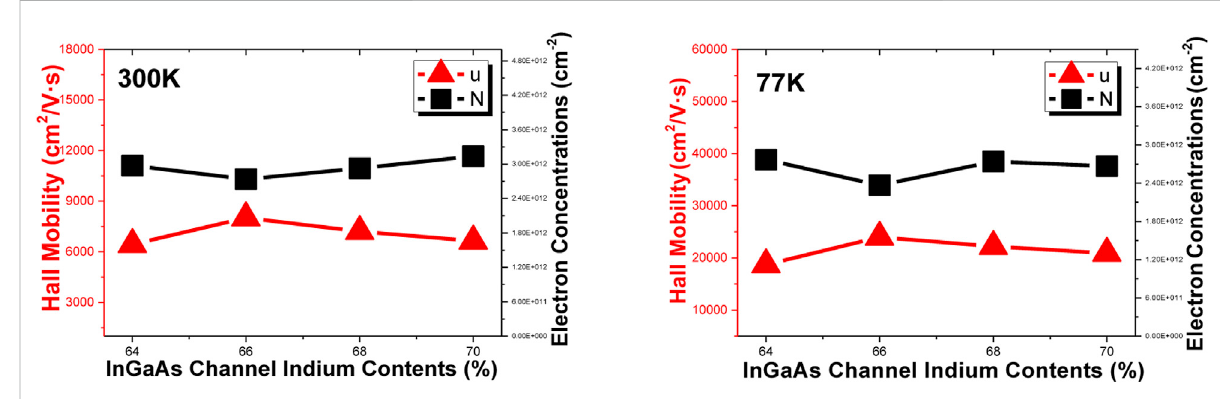
FIGURE 2 The 2-deg properties with different channel indium contents at 300K (77K).